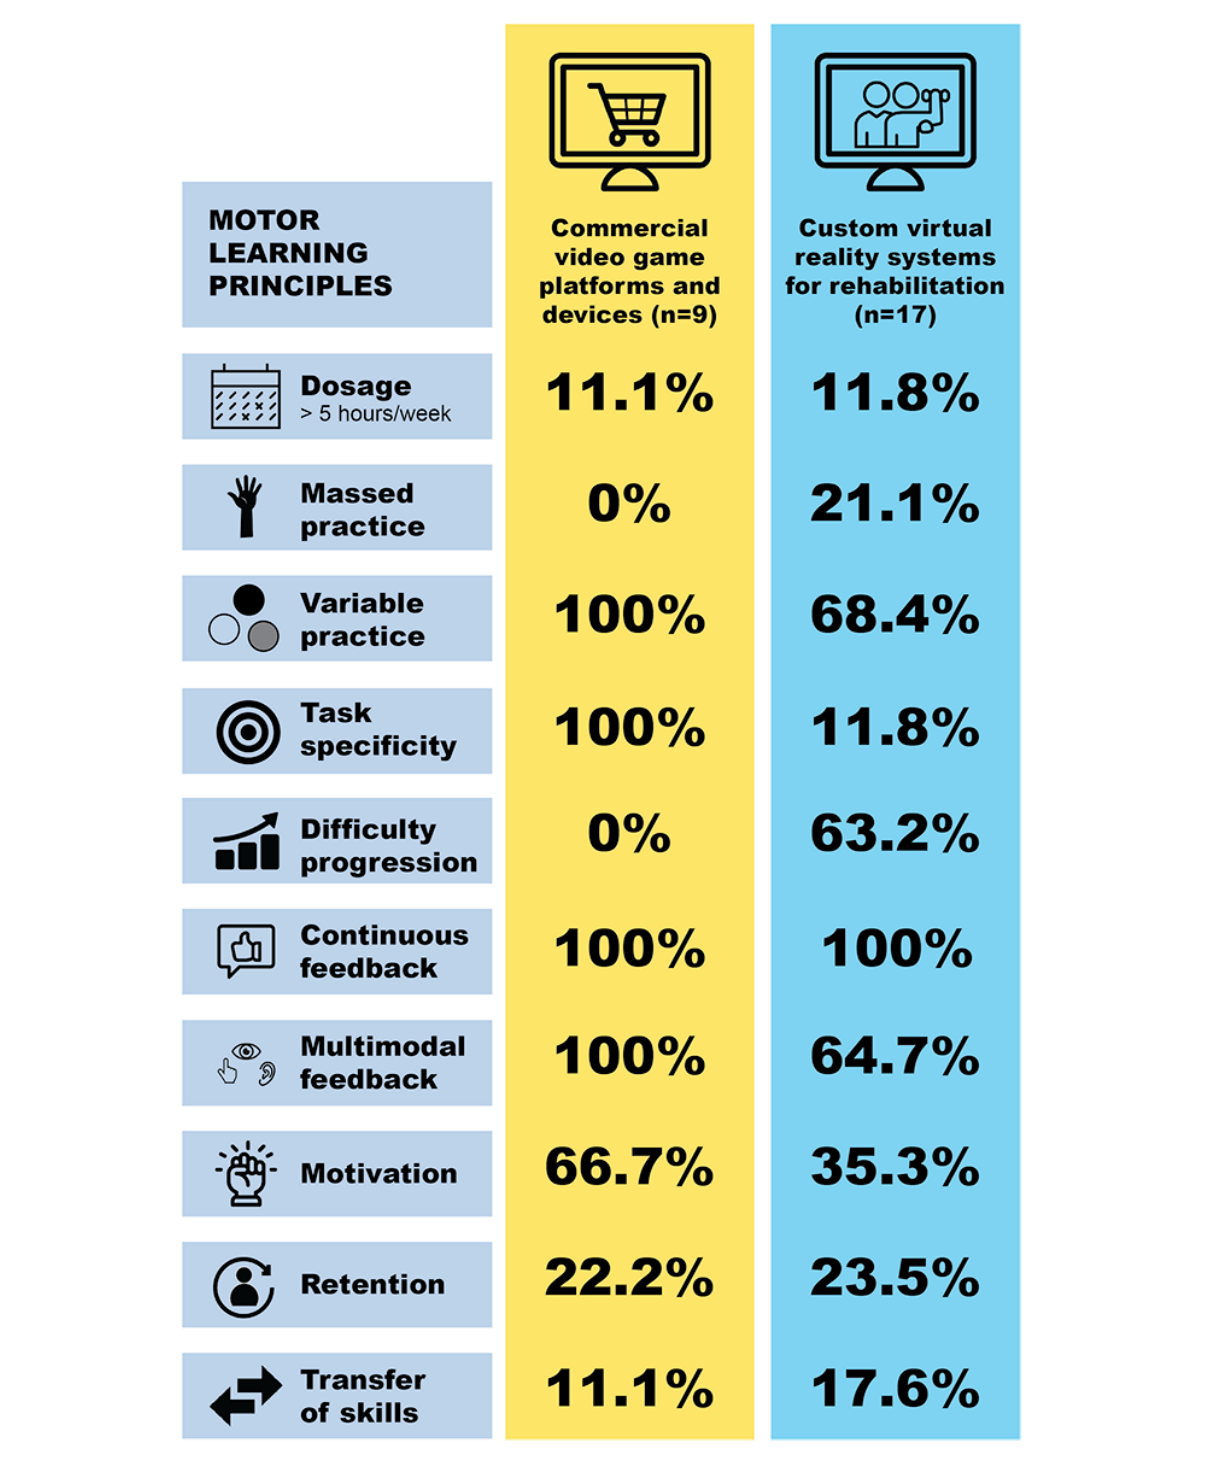
Figure 3. Percentage of commercial video game platforms and devices and custom virtual reality systems for rehabilitation integrating the principles of motor